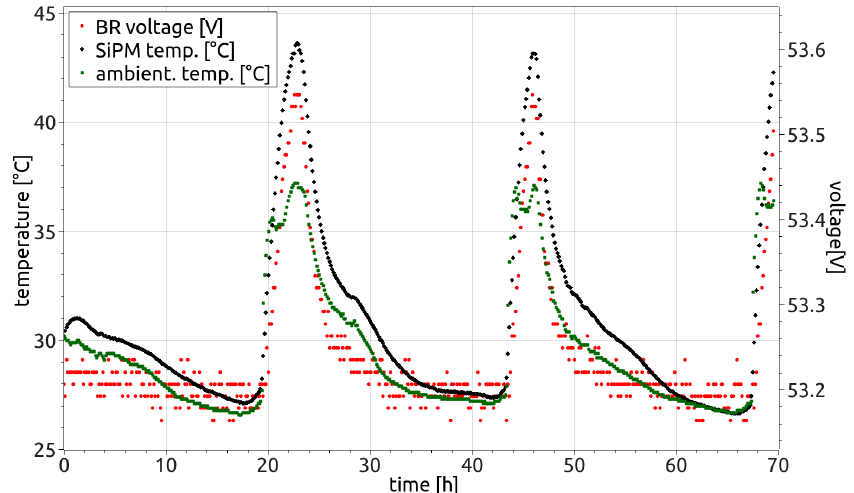
Figure 26. Long-term correlation of the breakdown voltage (cid:103) V BR , ambient temperature measured with a Keithley electrometer on the detector slab casing, and temperature measured by AFE near the SiPM. The ambient temperature was intentionally increased by placing the detector in sunlight during hot summer days. The calibration parameters of the AFE thermometer are taken from the vendor documentation.